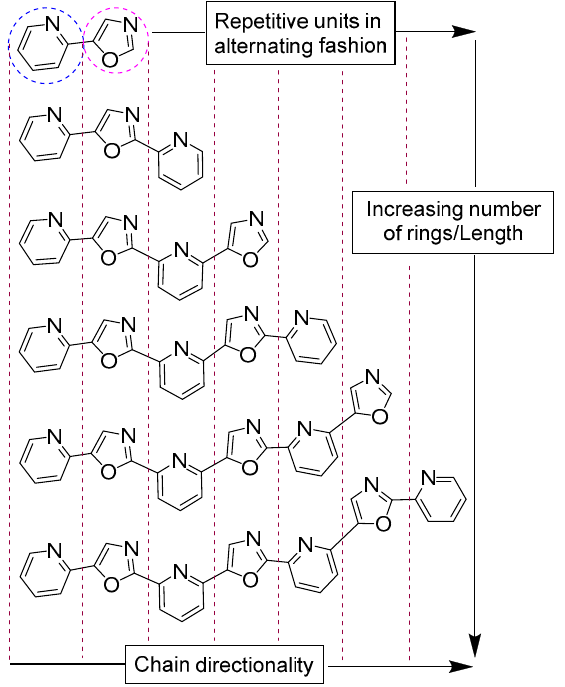
Figure 2. The library of ‘head-to-tail’-connected asymmetric pyridyl-oxazoles discussed in this study. The longer oligomers with 5–7 constituent rings were investigated for G-quadruplex interaction.